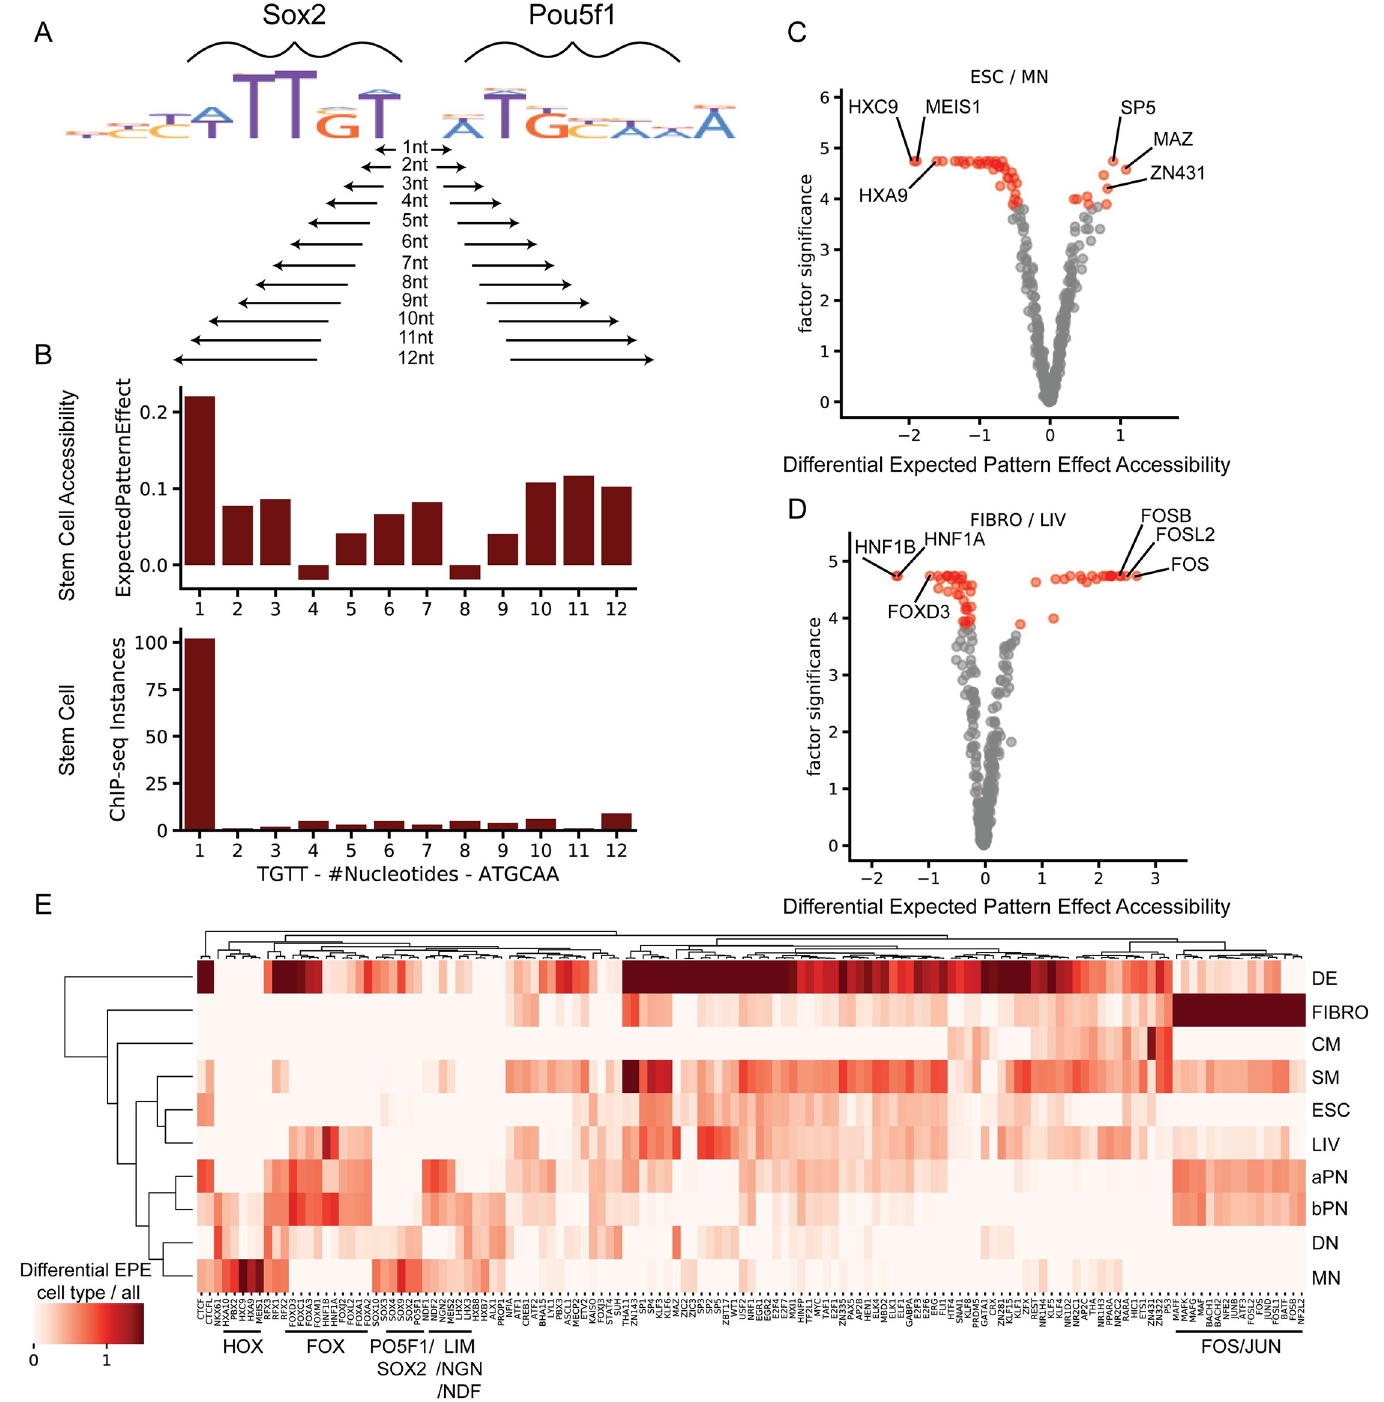
Fig 3. Expected Pattern Effect and Differential Expected Pattern Effect identify preferential spacing and cell type-specific transcription factor activity from DeepAccess models trained on chromatin accessibility data from ten cell types. (A) Testing all possible spacing between Sox2 transcription factor and Pou5f1 (Oct4) transcription factor motifs input as patterns to compute Expected Pattern Effects from a DeepAccess model. (B) DeepAccess Expected Pattern Effect of Sox2 and Pou5f1spacing on predicted stem cell accessibility (top) is consistent with highest score for preferred spacing of Sox2 and Pou5f1 motifs from ChIP-seq binding data of Sox2 and Pou5f1 co-binding events. (C) Differential EPE of transcription factor motifs between stem cells (ESC) and motor neurons (MN) identifies known MN-specific transcription factors such as Hox TFs and Meis. Scatter plot y-axis is unadjusted rank ratio statistic, x-axis is the Differential Expected Pattern Effect (log 2 fold change in Expected Pattern Effect between stem cells and motor neurons), with each point representing one of 356 HOCOMOCOv11 transcription factor motifs. Red points are